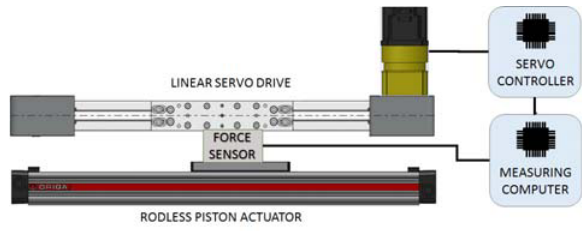
Fig. 4. Test rig for friction measurements.